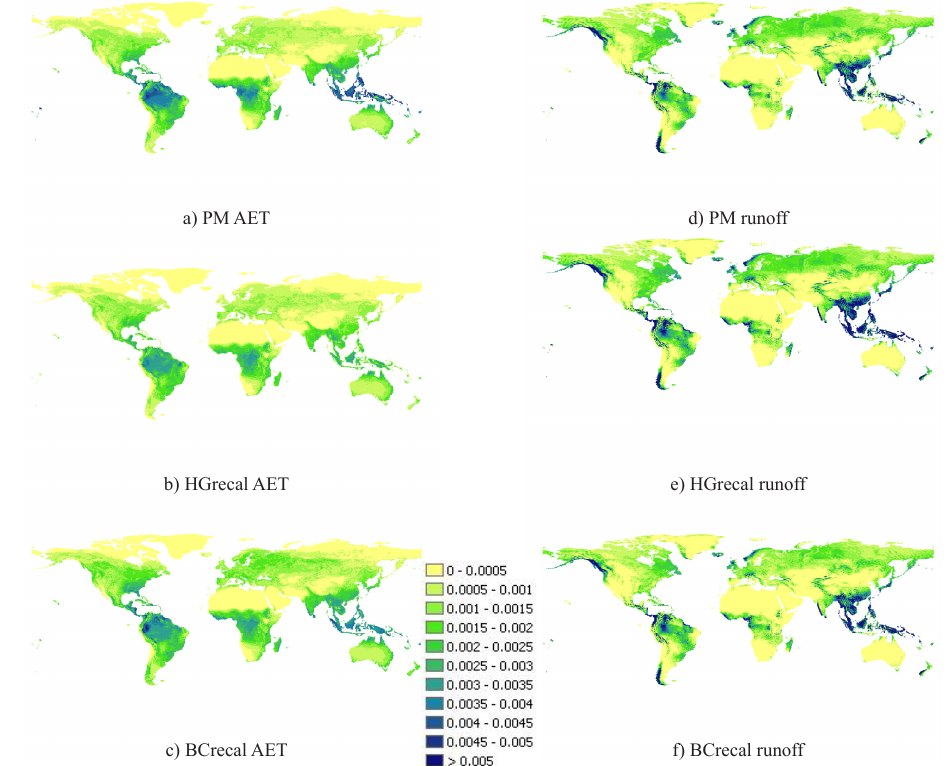
Fig. 7a. Global maps with on the left annual average daily actual evapotranspiration (mday − 1 ) and on the right annual average daily runoff (mday − 1 ) . From top to bottom, Penman-Monteith (PM), Hargreaves with increased multiplication factor (HGrecal) and re-calibrated Blaney-Criddle (BCrecal).